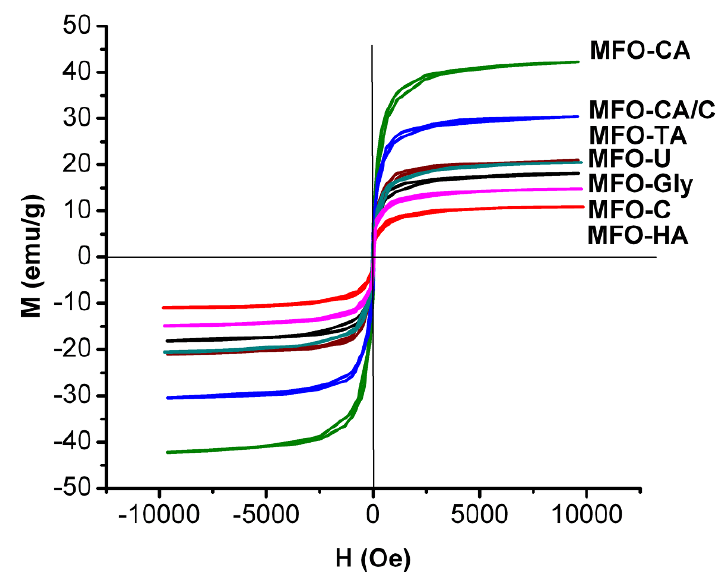
Figure 10. Room temperature hysteresis behavior for MFO heat treated at 1173